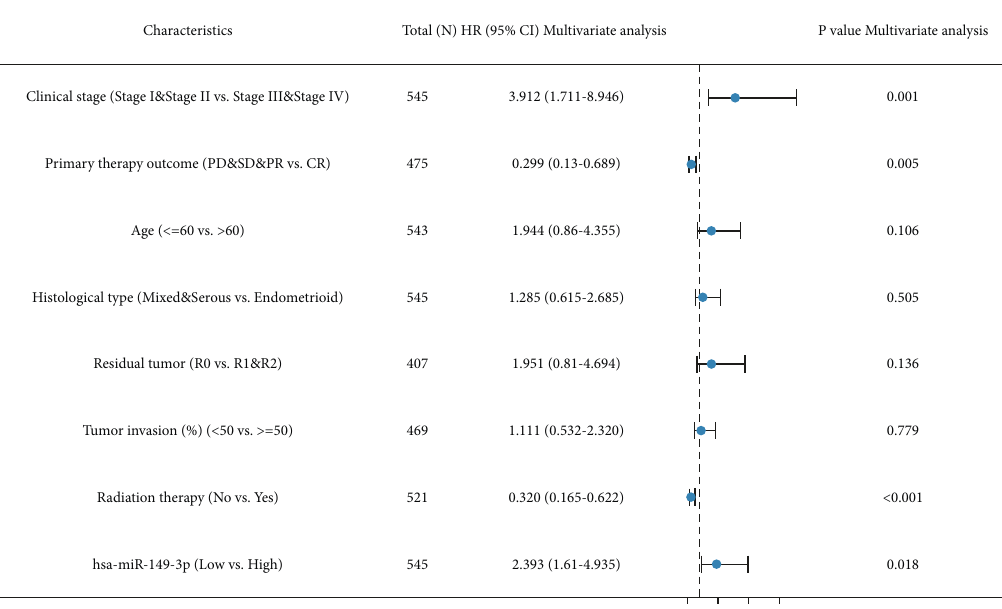
Figure 4: UCEC for multivariate Cox regression analysis of forest plots.